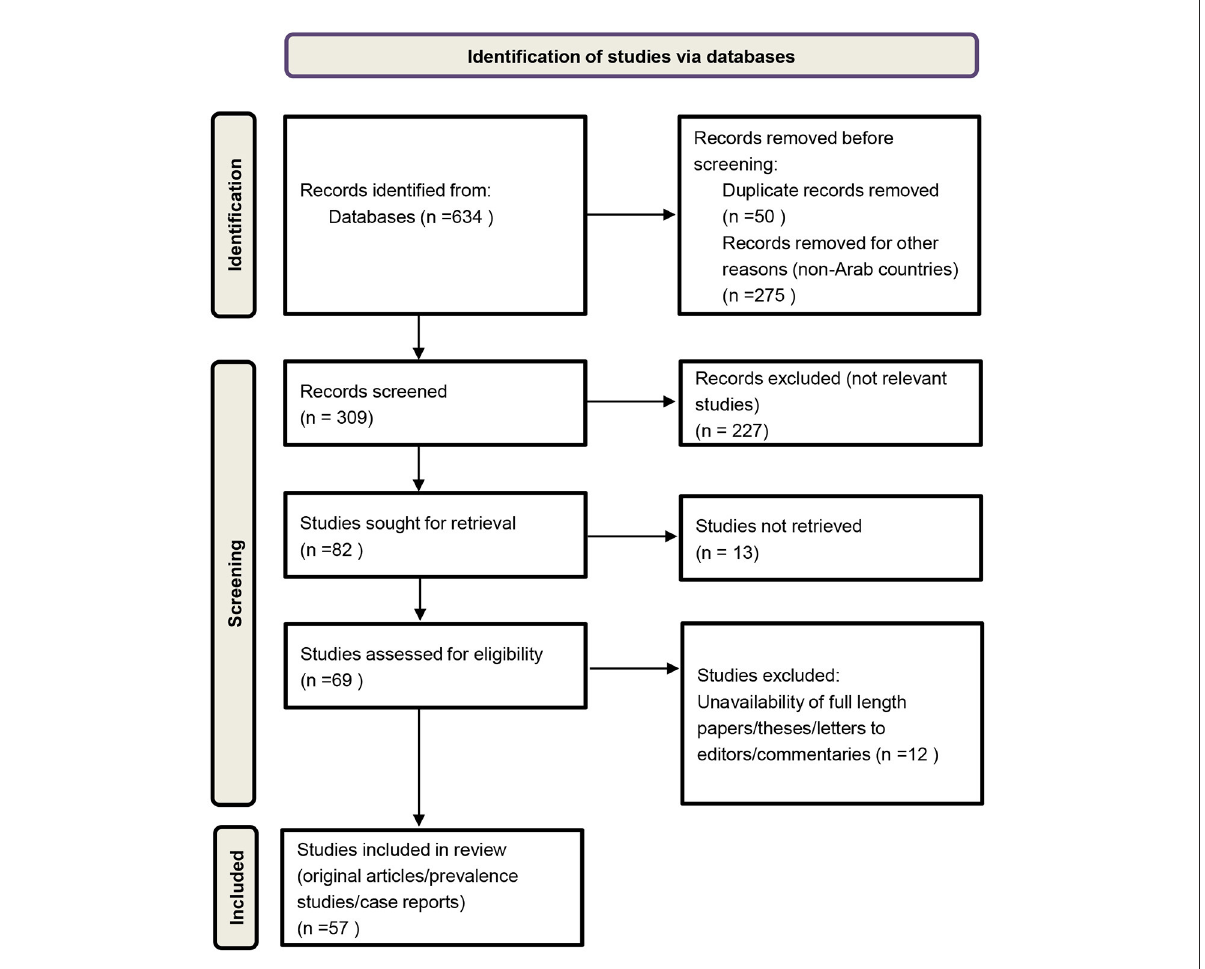
FIGURE1 Flow chart diagram for data retrieving and